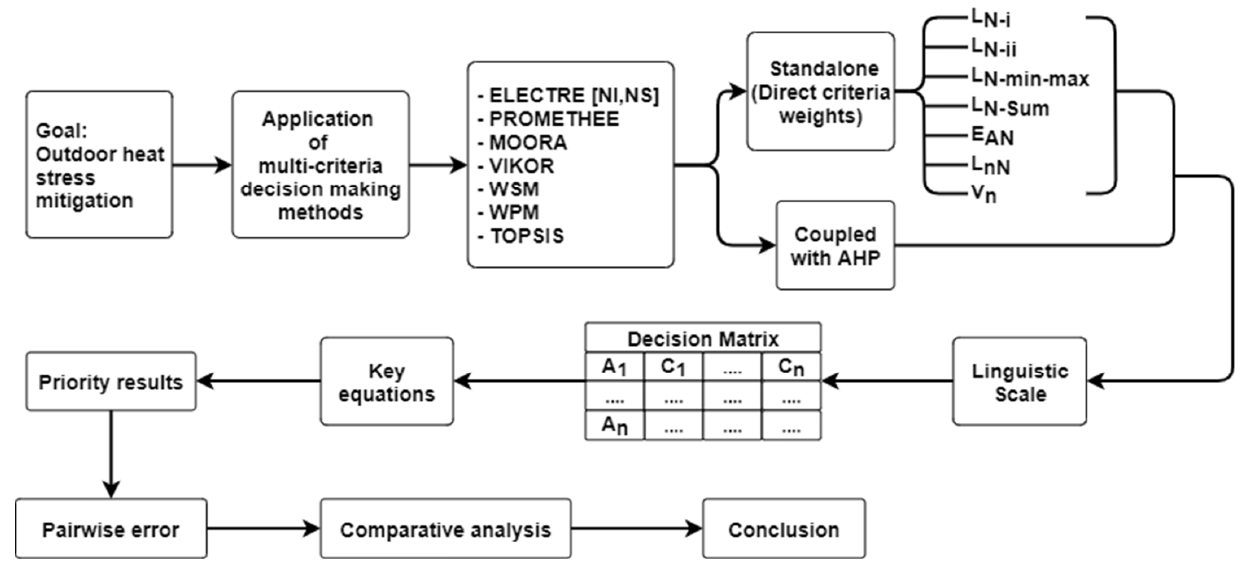
Figure 2. Linguistic scale for rating the importance of criteria and performance of alternatives.